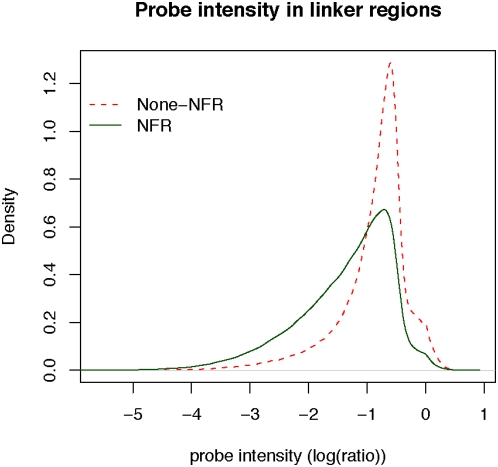
A comparison of intensities of linker probes between those that are inside NFRs and those that are outside of NFRs.The probe intensity is measured by the raw data of nucleosome occupancy, i.e., log(ratio) from Lee et al. [6]. A density distribution (green line) is plotted for the intensity of linker probes (defined in Lee et al. [6]) that are also present in NFRs (defined in this study). A similar curve was shown for linker probes that locate outside of NFRs (red line).